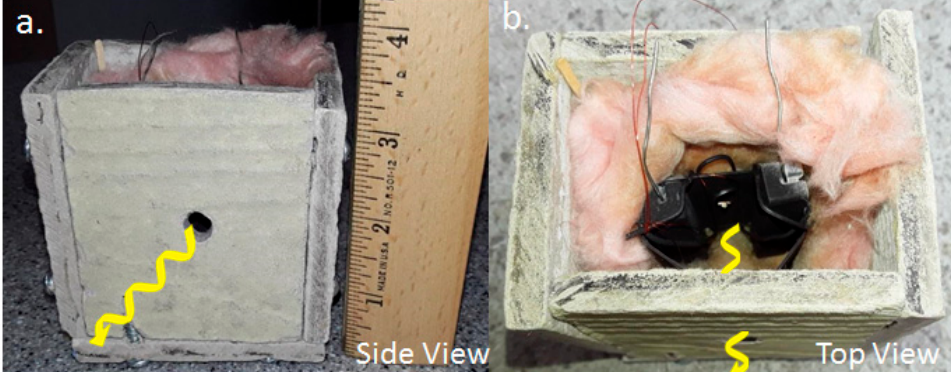
Figure 3. ( a ) Front of LED Box, indicating box dimensions and showing aperture. The box is made of cement board and held together with screws. ( b ) View of Inside of LED Box, showing position of LED (bright spot in center), mounting plate, across top of inside assembly, Heating Power resistors (black cylinders) at left and right. Wires run to Heater Power and Thermocouple Voltmeter.